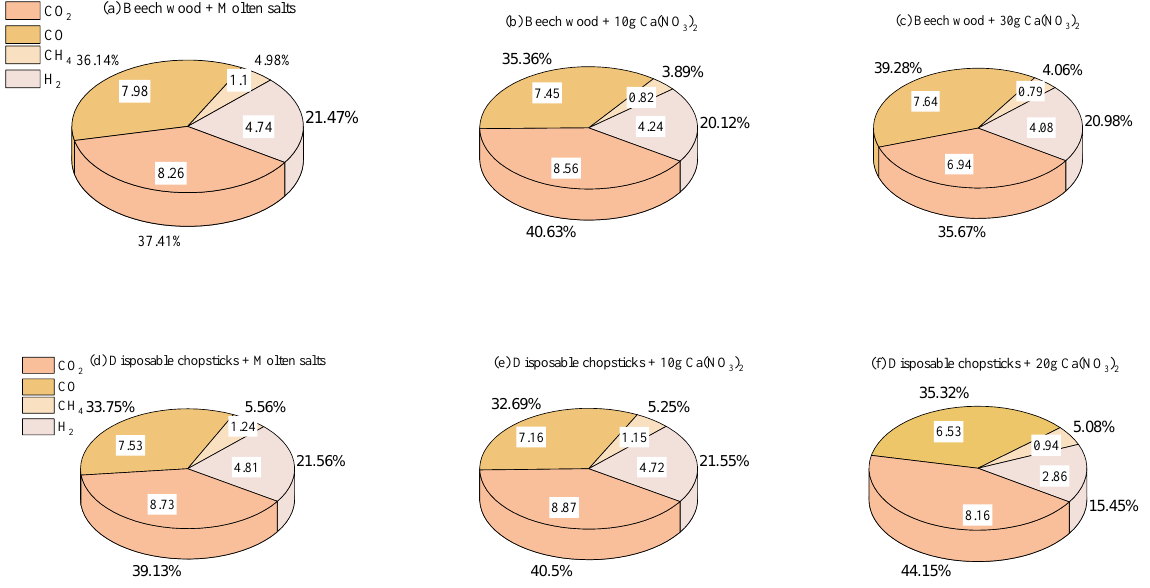
Figure 3. Gas distribution characteristics of the bio-wastes during NaNO 3 -NaNO 2 adding Ca(NO 3 ) 2 ( a – c ) Beech wood ( d – f ) Disposable chopsticks.